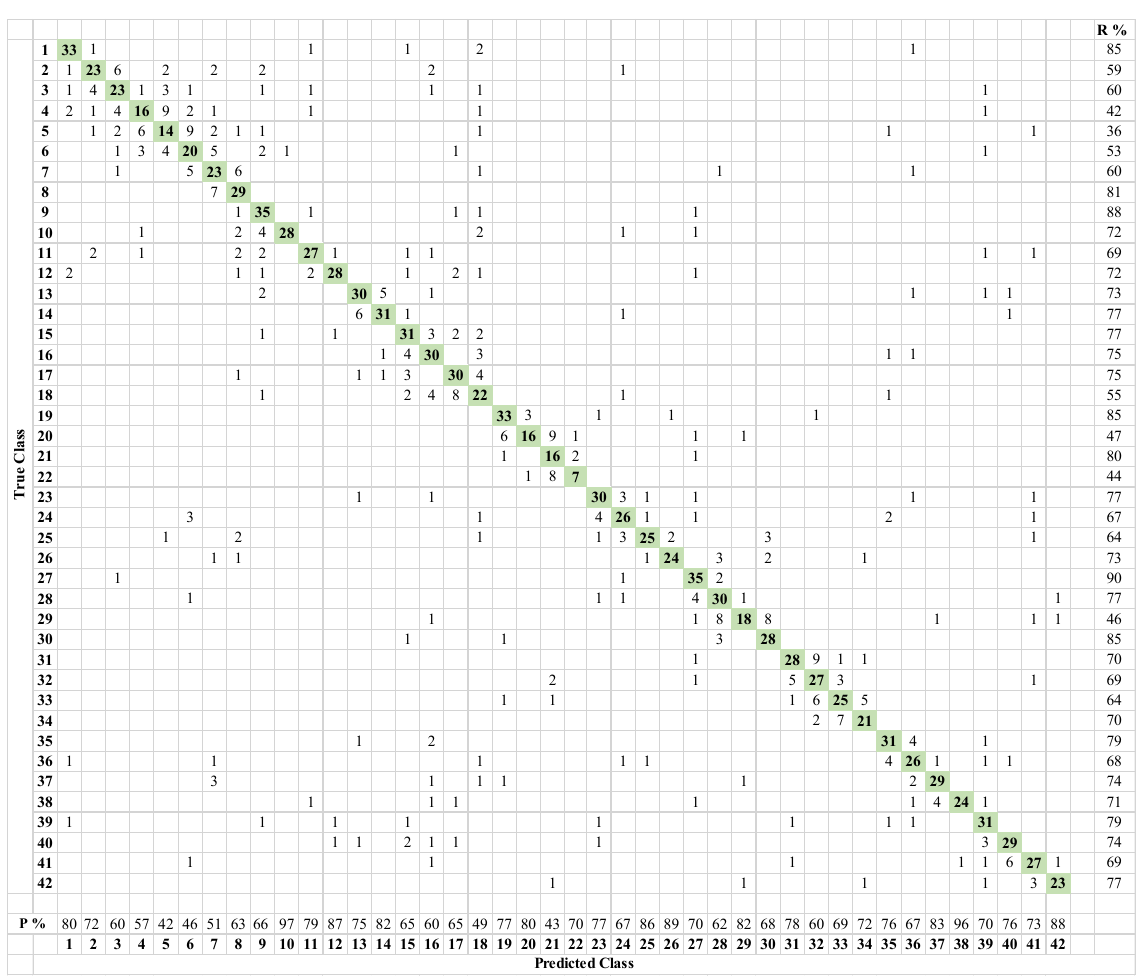
Figure 10. Test confusion matrix of ResNet18 on 10% of original dataset, 69.49% test classification accuracy. (1: normal; 2–8: unbalance with (6, 10, 15, 20, 25, 30, 35) g mass; 9–12: horizontal misalignment of (0.5, 1, 1.5, 2) mm; 13–18: vertical misalignment of (0.51, 0.63, 1.27, 1.4, 1.78, 1.9) mm; 19–22: overhung position ball fault with (0, 6, 20, 35) g unbalance; 23–26: overhung position cage fault with (0, 6, 20, 35) g unbalance; 27–30: overhung position outer race fault with (0, 6, 20, 35) g unbalance; 31–34: underhung position ball fault with (0, 6, 20, 35) g unbalance; 35–38: underhung position cage fault with (0, 6, 20, 35) g unbalance; 39–42: underhung position outer race fault with (0, 6, 20, 35) g unbalance) (R: Recall, P: Precision).